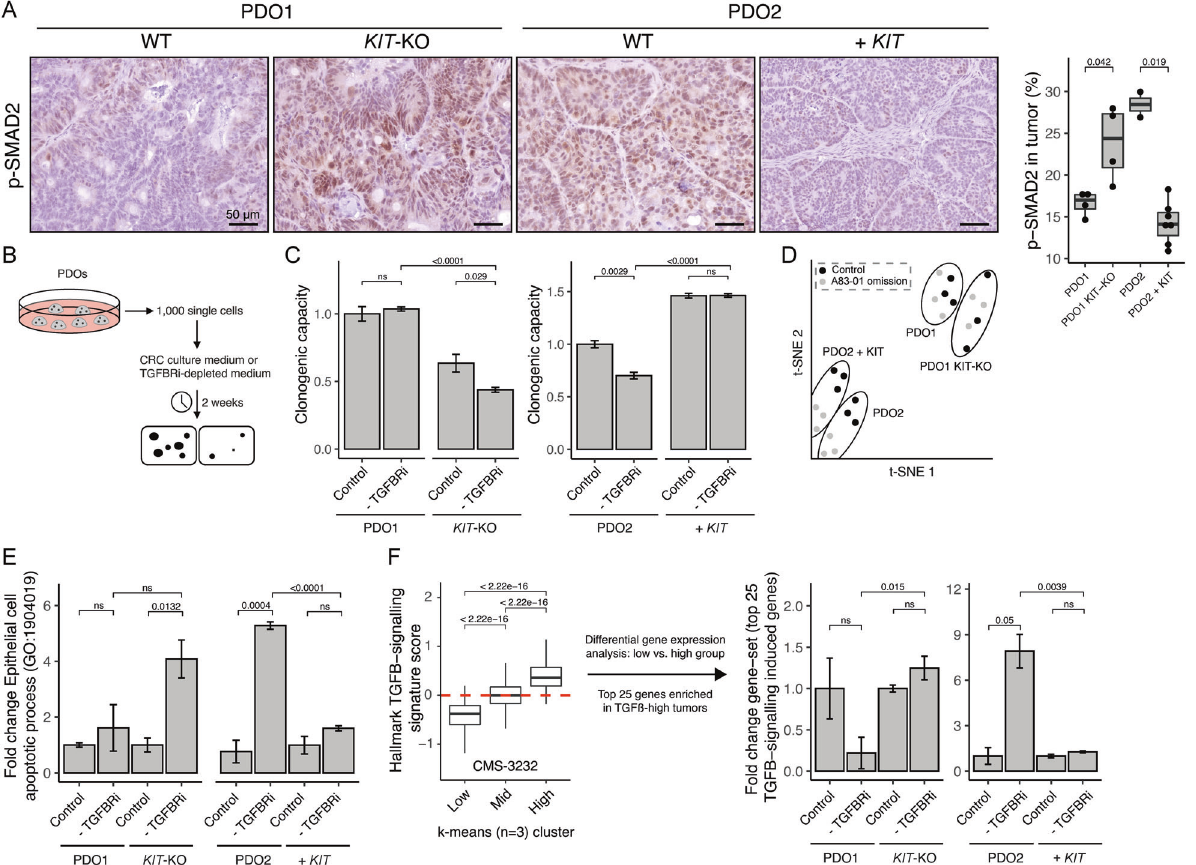
Fig. 5 KIT counteracts tumor-suppressive TGF β -signaling. A Histological images of p-SMAD2 in s.c. tumors and corresponding quanti fi cation. B Schematic overview of the regenerative capacity assay, in which 1000 single cells are seeded in CRC culture medium or A83-01 depleted medium. The number of organoids are counted after two weeks. C Quanti fi cation of the regenerative capacity assay as described in ( B ), at least two different experiments with three technical replicates in each. D t-SNE projection of RNA-sequencing data of in vitro PDOs, grown in CRC culture medium (control) or TGFBRi-depleted (A83-01 omission) medium. E Bar plot showing fold change of “ Epithelial cell apoptotic process (GO: 1904019) ” . F A “ TGFB-response ” gene set is generated by using the k-means algorithm and clustering the CMS-3232 cohort into three groups, de fi ned by low-, intermediate- and high expression for the hallmark TGFB-signaling signature. The score for the top 25 genes upregulated in the TGFB-High group is assessed in the RNA-sequencing data of the regenerative capacity assay in ( C ). An unpaired t-test was applied to assess the signi fi cance between the